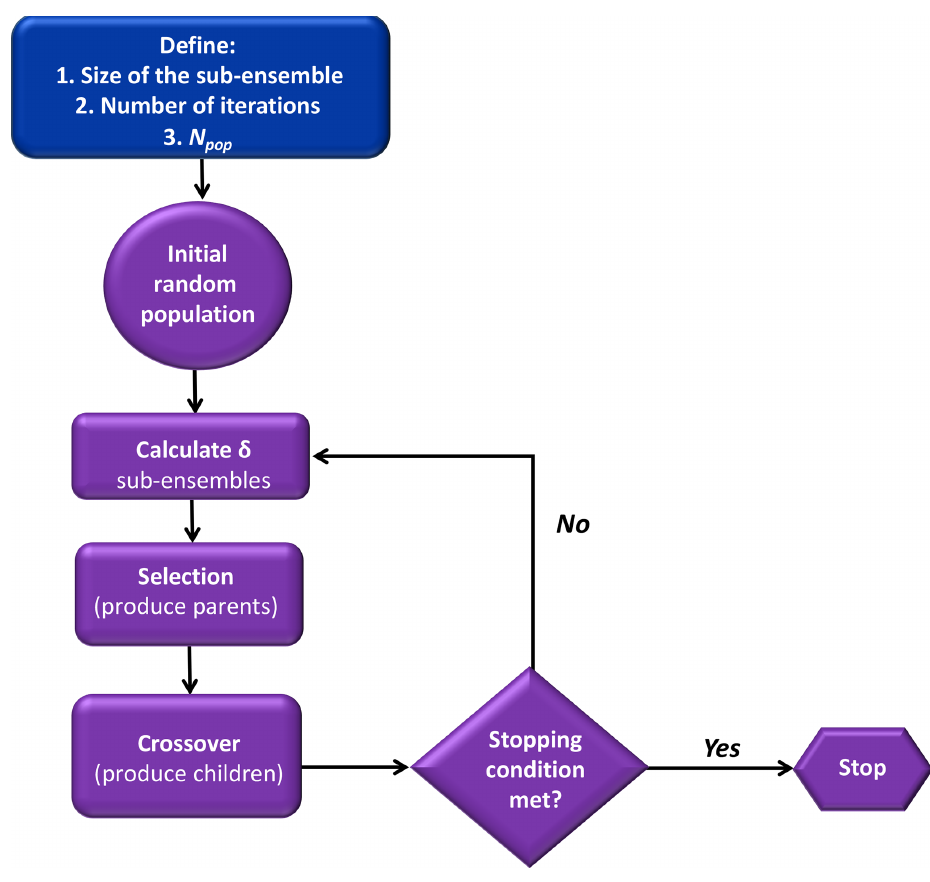
Figure A3. Diagram of the genetic